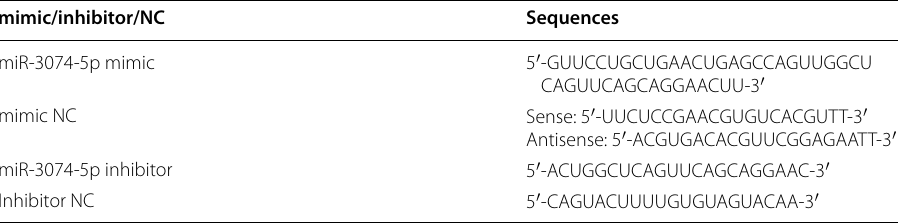
Table 1 Sequences of mimic, mimic NC, inhibitor, and inhibitor NC